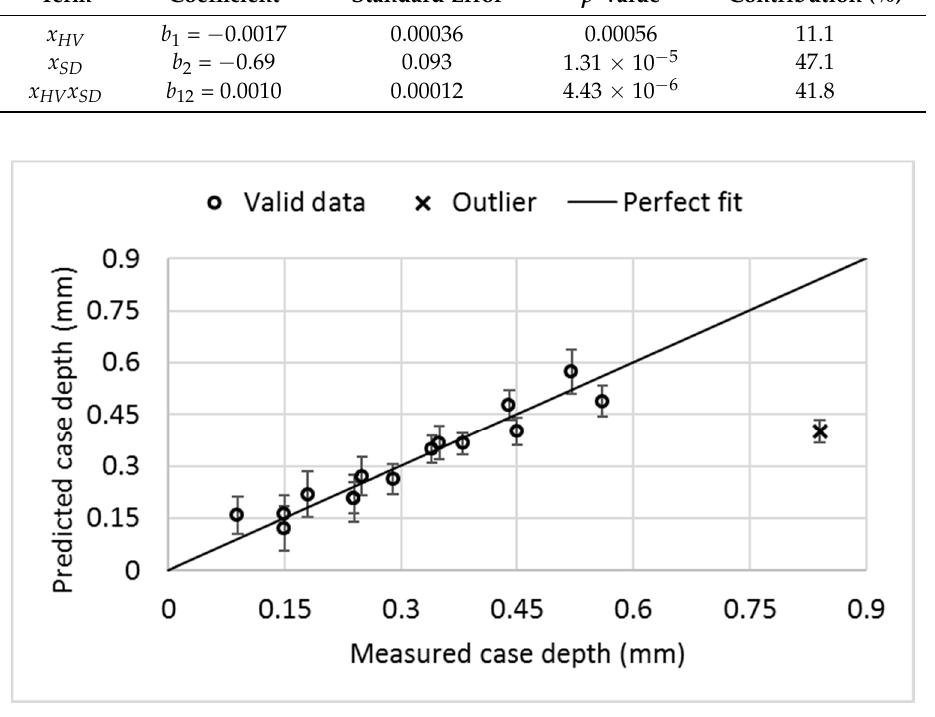
Figure 9. Predicted vs. measured case depth with the ground sample data set.